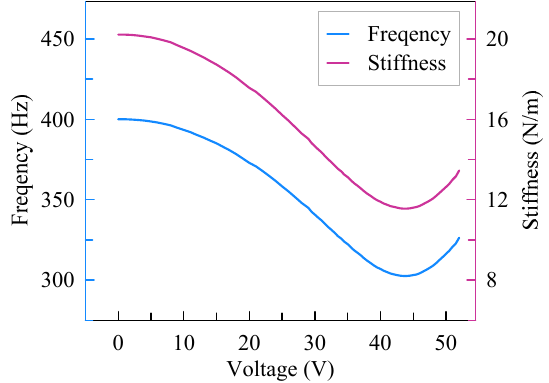
Figure 10. Frequency and stiffness variation.